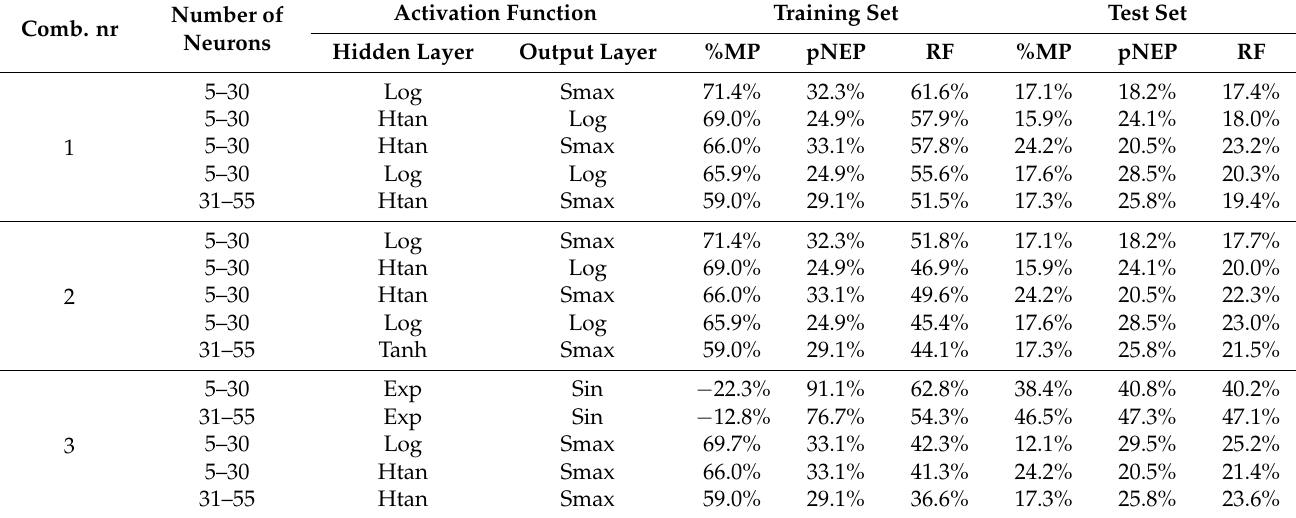
Table 7. The best results obtained for a given combination of weight